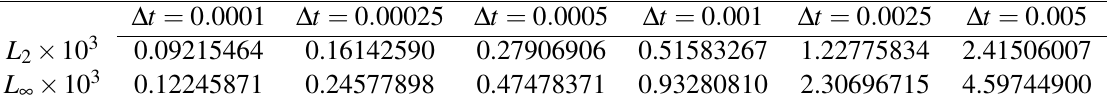
Table 6 Comparison of results at t f = 1 . 0 for ν =1, N = 40 and various time steps ∆ t = 0 . 0001 ∆ t = 0 . 00025 ∆ t = 0 . 0005